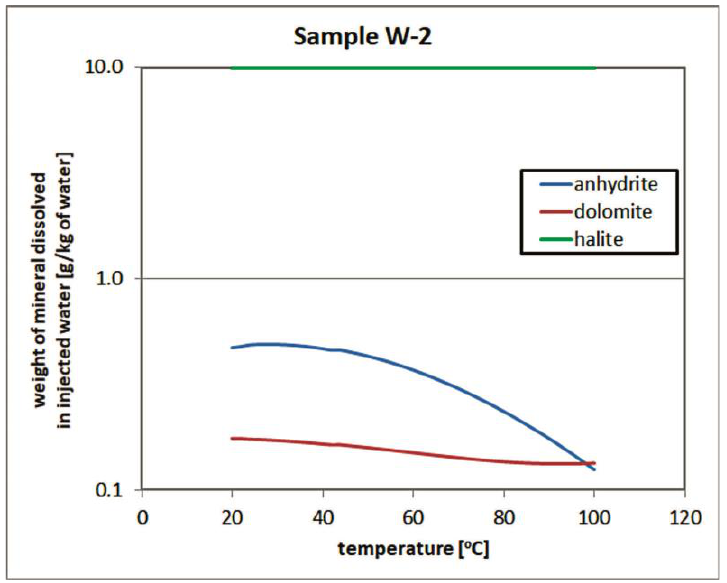
Figure 8. Changes in solubility of rock matrix minerals in W-2 injected water as function of tem- perature.